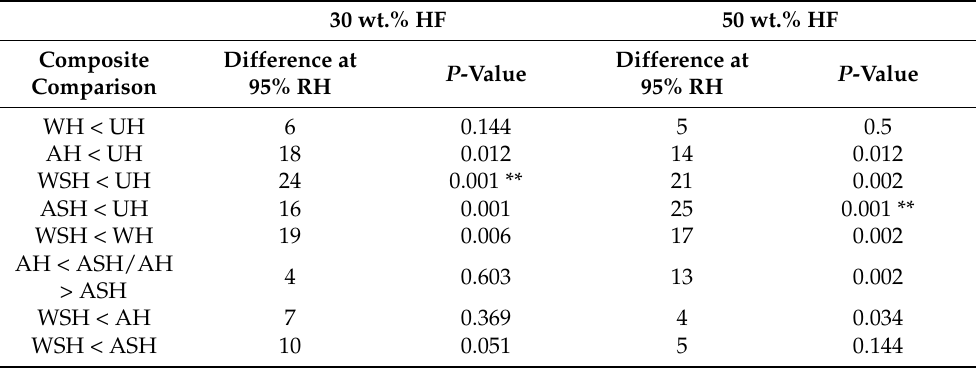
Table 4. The differences between the EMC of the HPLA composites (30 and 50 wt.%) at 95% RH and the obtained P -value from an alpha of 0.05 (ANOVA single factor